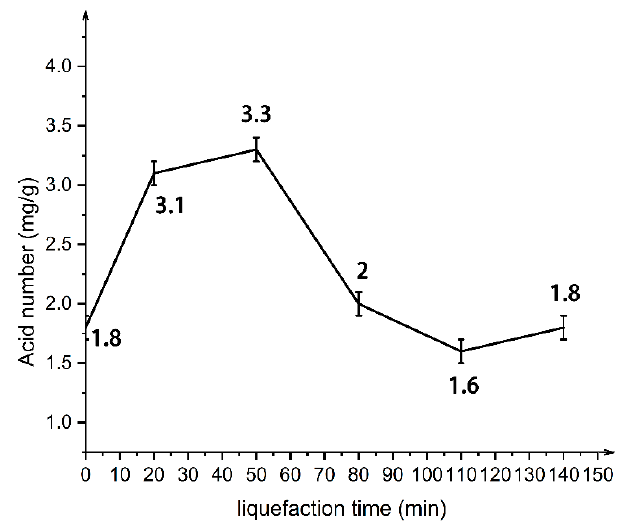
Figure 8. Acid number of liquefied products at different liquefaction times.